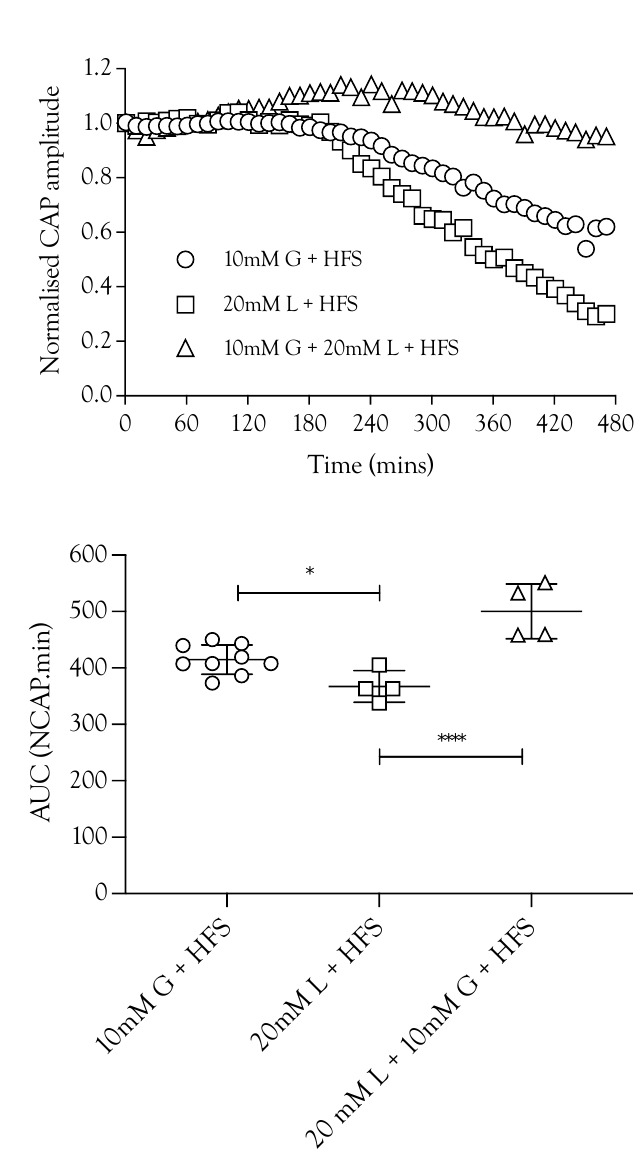
Figure 3. Lactate acts as an energy source for A fibres during HFS. ( A ) Substitution of 10 mM glucose with 20 mM lactate during HFS significantly reduced the CAP area. The combination of 10 mM glucose and 20 mM lactate enabled full maintenance of conduction. ( B ) The A fibre CAP was partially maintained in 10 mM glucose and HFS (414.9 ± 26.0 NCAP.mins, n = 9). Replacement of glucose with 20 mM lactate decreased CAP support (367.2 ± 28 NCAP.mins, n = 4), but combination of 10 mM glucose and 20 mM lactate increased the maintenance of conduction compared to 10 mM glucose alone during HFS (500.3 ± 48.7 NCAP.mins, n = 4) (**** = p ≤ 0.0001, * = p ≤ 0.05) .